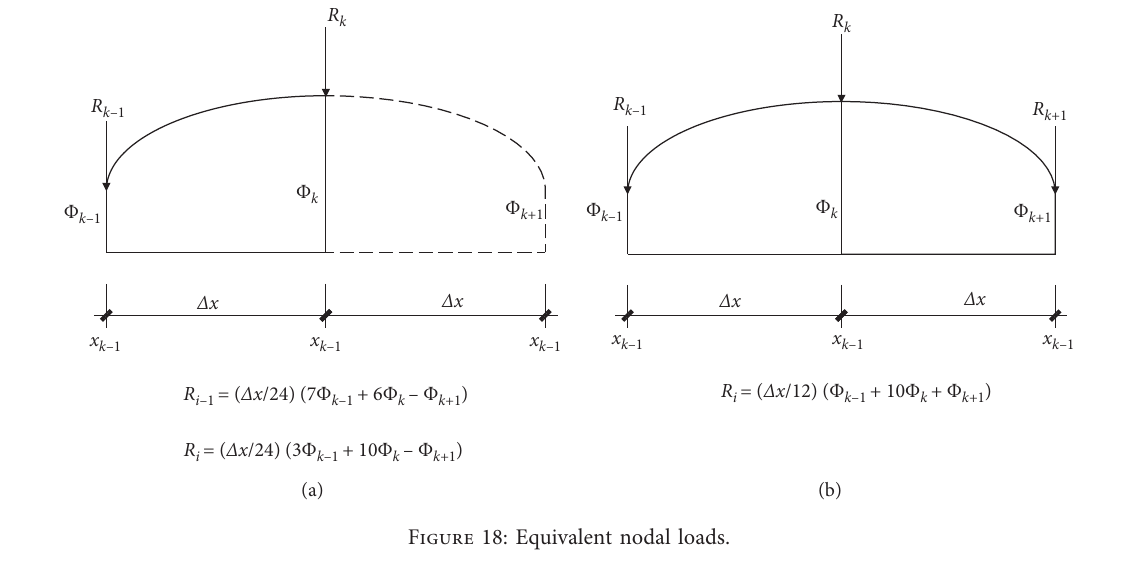
Figure 18: Equivalent nodal